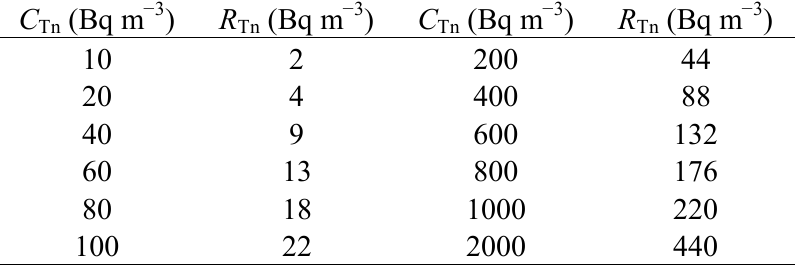
1. Thoron concentrations, C concentrations, R . Tn C (Bq m − 3 Tn